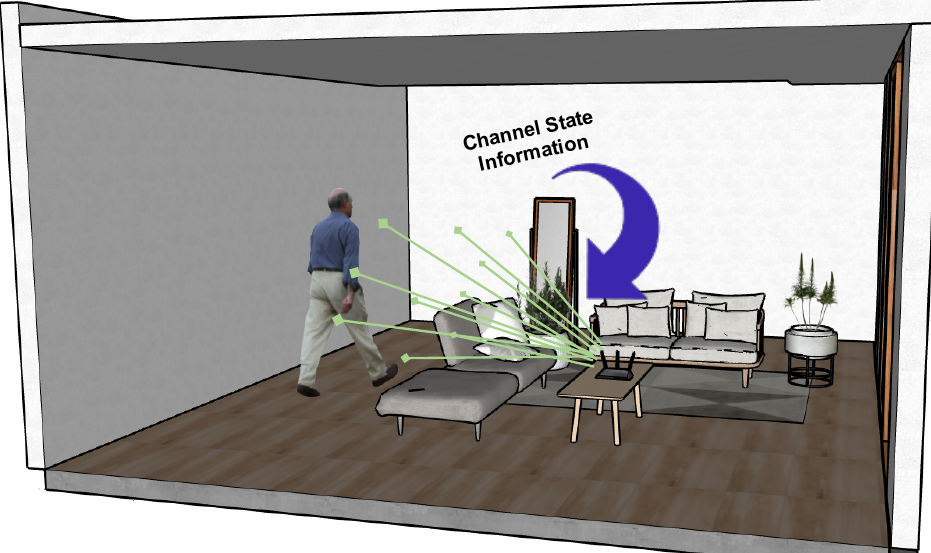
Figure 3. Activity monitoring using Ambient RF